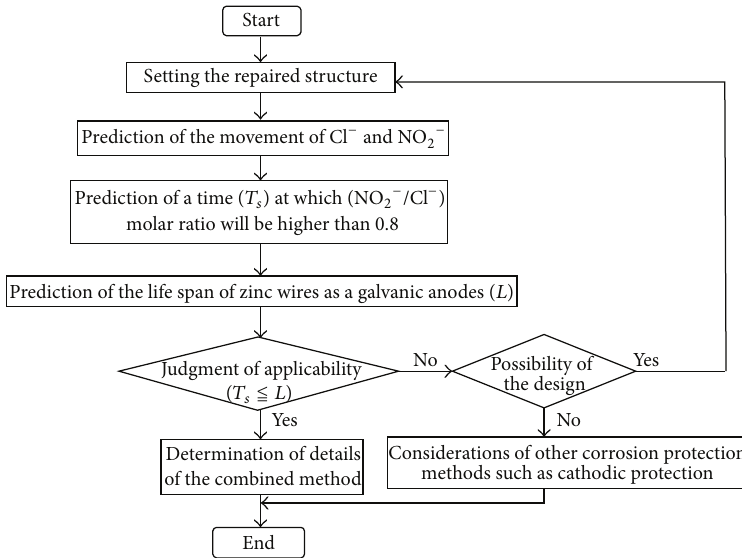
Figure 13: Flow chart of the design.